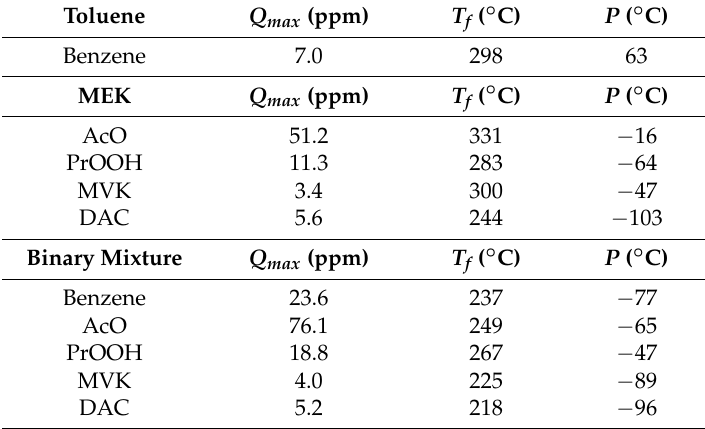
Figure 7. Binary mixture conversion and byproduct formation versus temperature for Pd/CeO 2 catalyst. Table 7. Parameters characterizing the emission profiles on Pd/CeO 2 of byproducts for VOCs alone and in binary mixture.